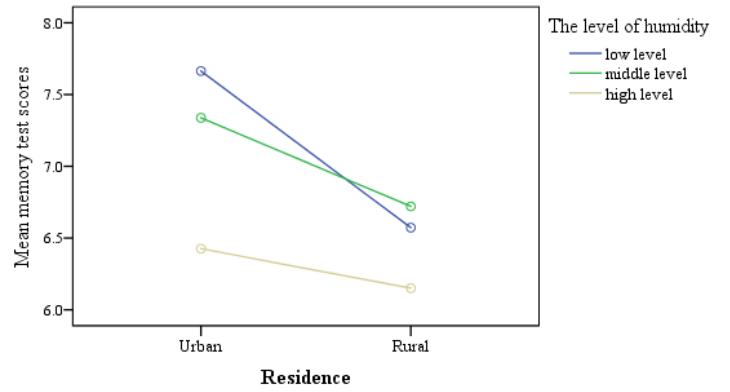
Figure 2. The memory scores between urban and rural areas under different humidity levels.